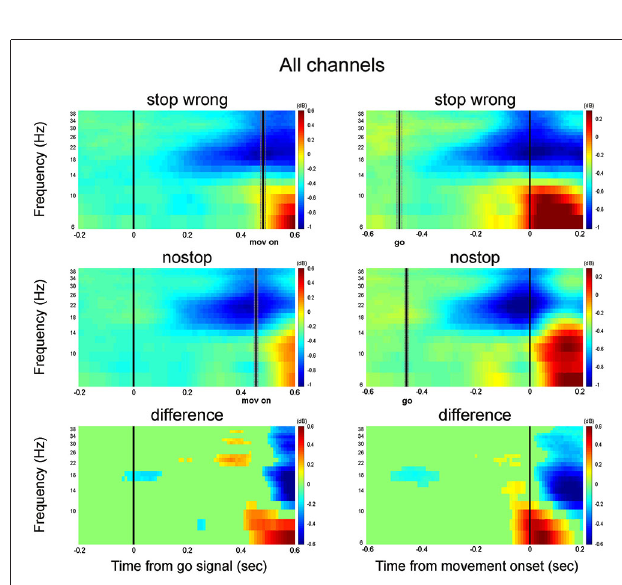
FIGURE 7 | Grand average time-frequency plot showing the LFP activity of wrong stop trials (upper panels) and latency-matched no-stop trials (middle panels) and their difference (bottom panels) . Data are presented